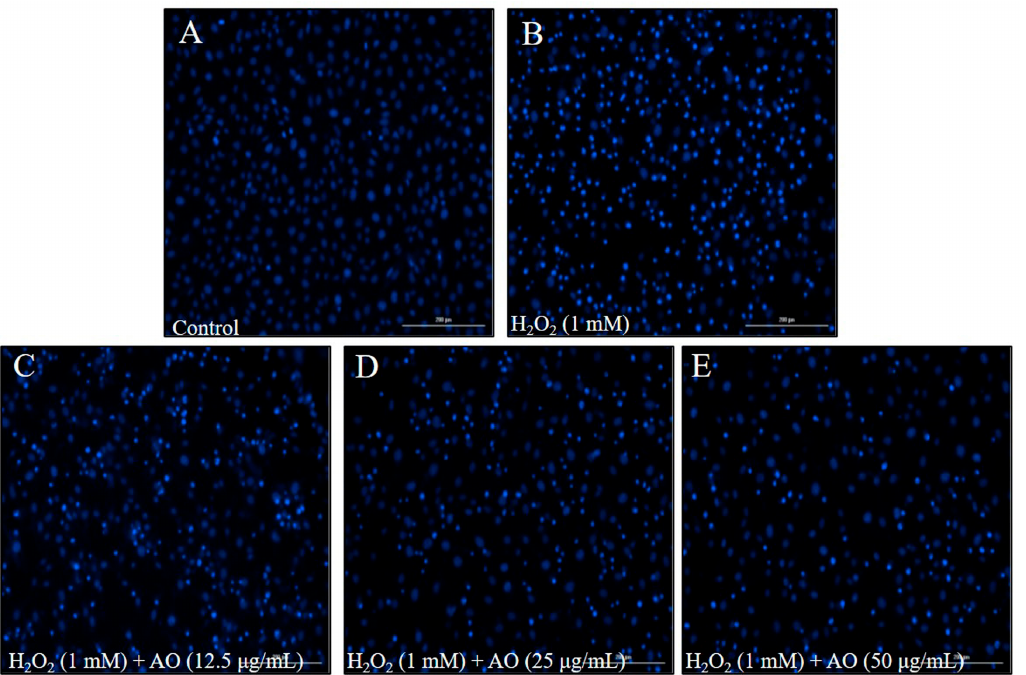
Figure 2. The effect of AO on H 2 O 2 -stimulated apoptosis in Vero cells. ( A ) Nuclear morphology of non H 2 O 2 -treated Vero cells; ( B ) nuclear morphology of H 2 O 2 -treated Vero cells; ( C ) nuclear morphology of Vero cells treated with 12.5 µ g/mL of AO and H 2 O 2 ; ( D ) nuclear morphology of cells treated with 50 μ g/mL of AO and H 2 O 2 ; ( E ) nuclear morphology of cells treated with 100 μ g/mL of AO and H 2 O 2 .